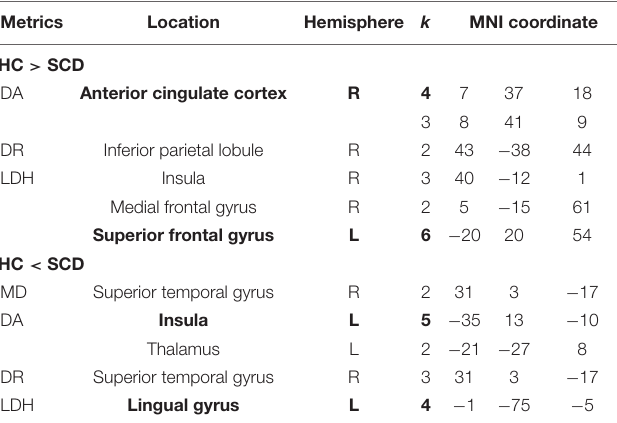
significant between-group differences of DA values in the left insula were found either in the ROIs with radius = 3 mm (number of voxels = 40, p = 0.183, Cohen’s d = − 0.468) or radius = 5 mm (number of voxels = 86, p = 0.191, Cohen’s d = −